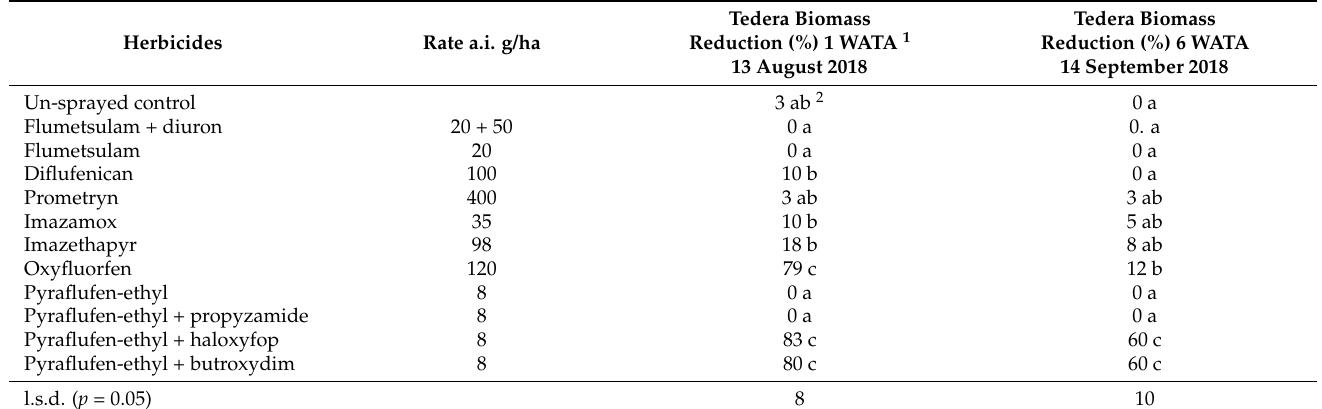
Table 6. Response of 1-month-old tedera seedlings to post-emergent broadleaf herbicides applied on 5 August 2018 (5 weeks after sowing) at